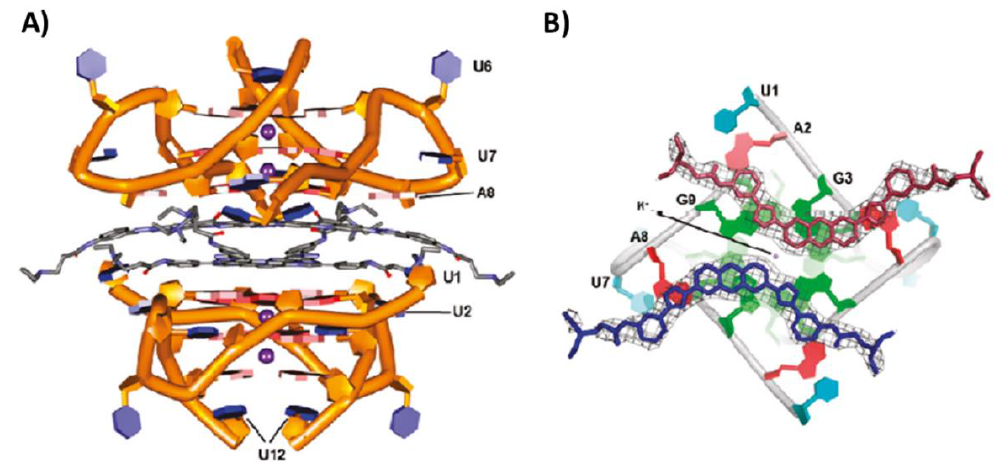
Figure 10. ( A ) Crystal structure of the complex between the bimolecular parallel G-quadruplex hr-tel12 of sequence r[(UAGGGU) 2 ] and a 3,6-disubstituted acridine. G-quadruplex units are 5′ - 5′ stacked. Details of the ligand binding are highlighted in ( B ). Adapted with permission from ref. [84], Copyright 2011 American Chemical Society.